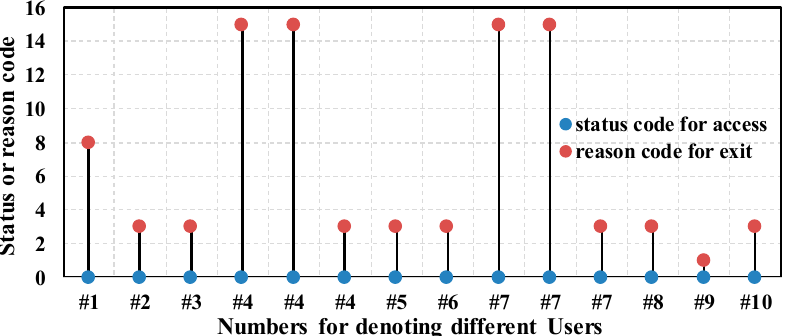
Figure 10. Status codes and reason codes.